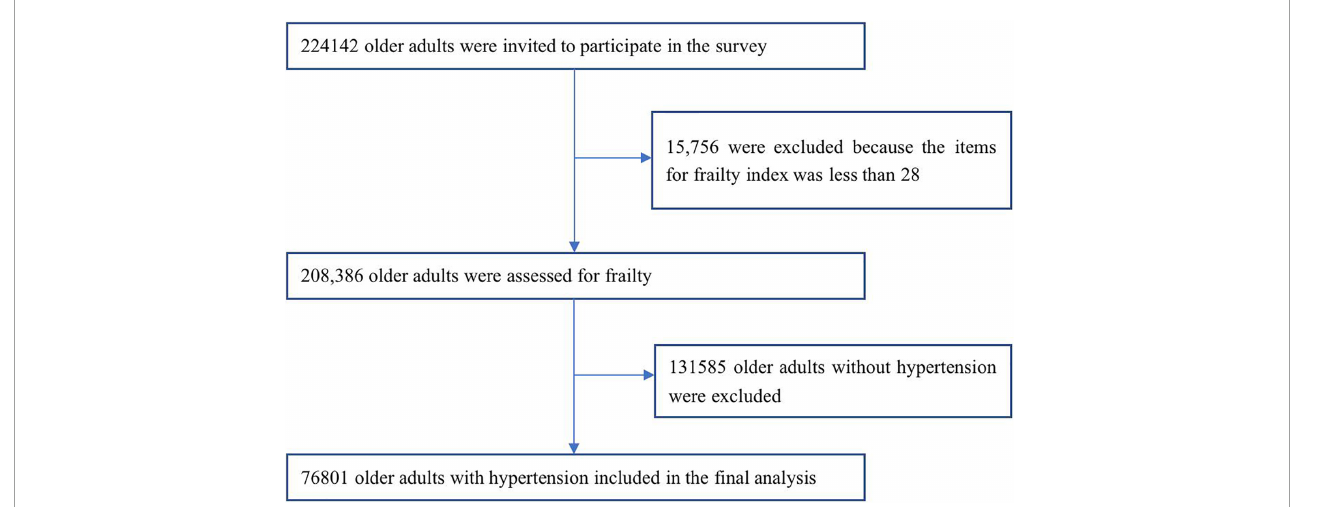
FIGURE1 Flowchart of study participants on frailty and pre-frailty prevalence in older adults with hypertension in